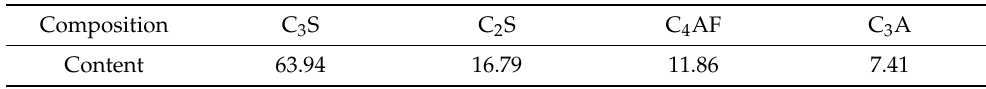
Table 1. Mineral composition of cement (%).